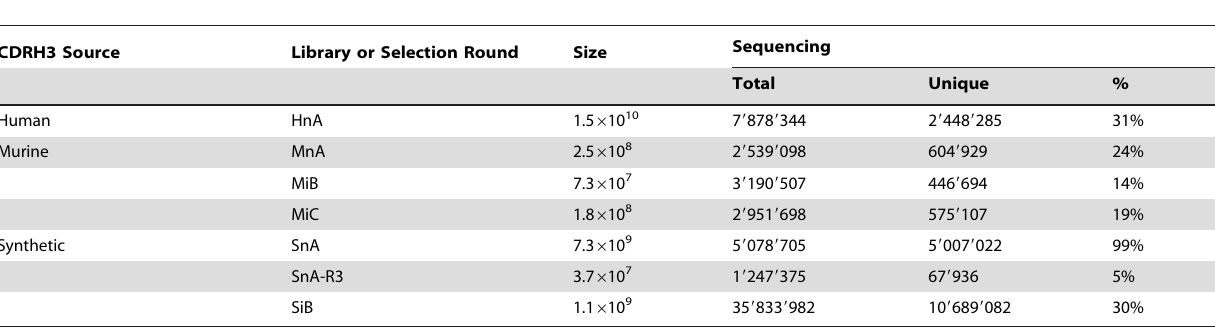
Table 1. Summary of captured CDRH3 diversity and analysis of libraries by NGS.